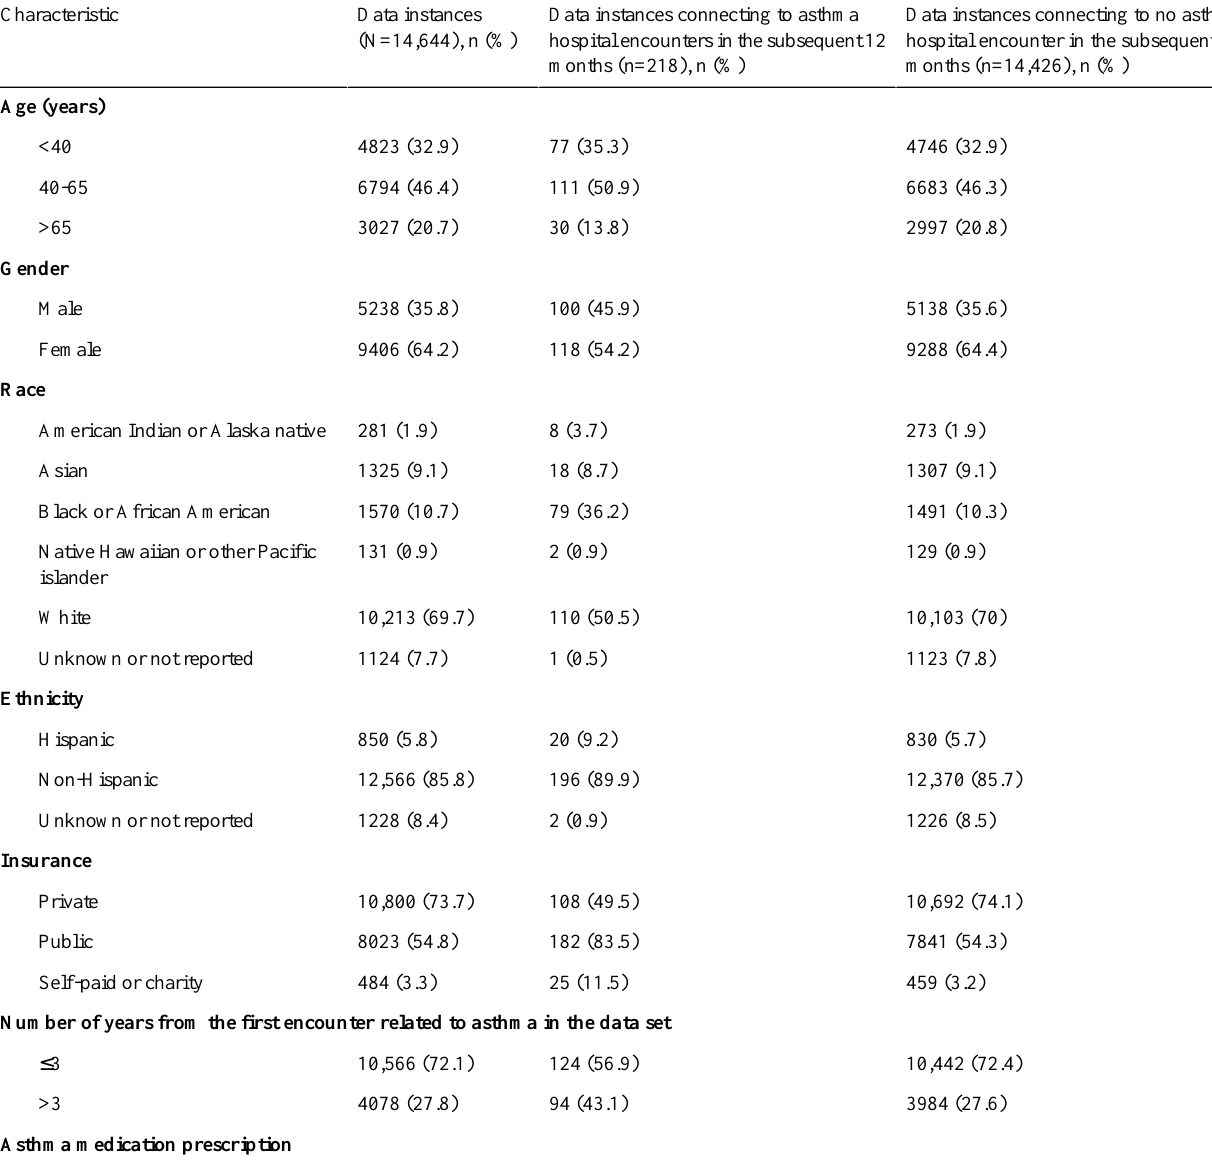
Table 3. Demographic and clinical characteristics of patients with asthma at the University of Washington Medicine in